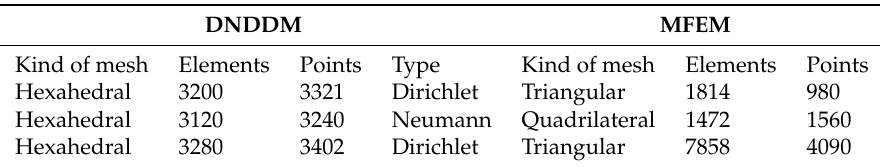
Table 2. DNDDM and MFEM